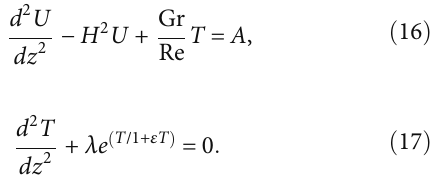
Figure 1: An instance of the considered model in geometric